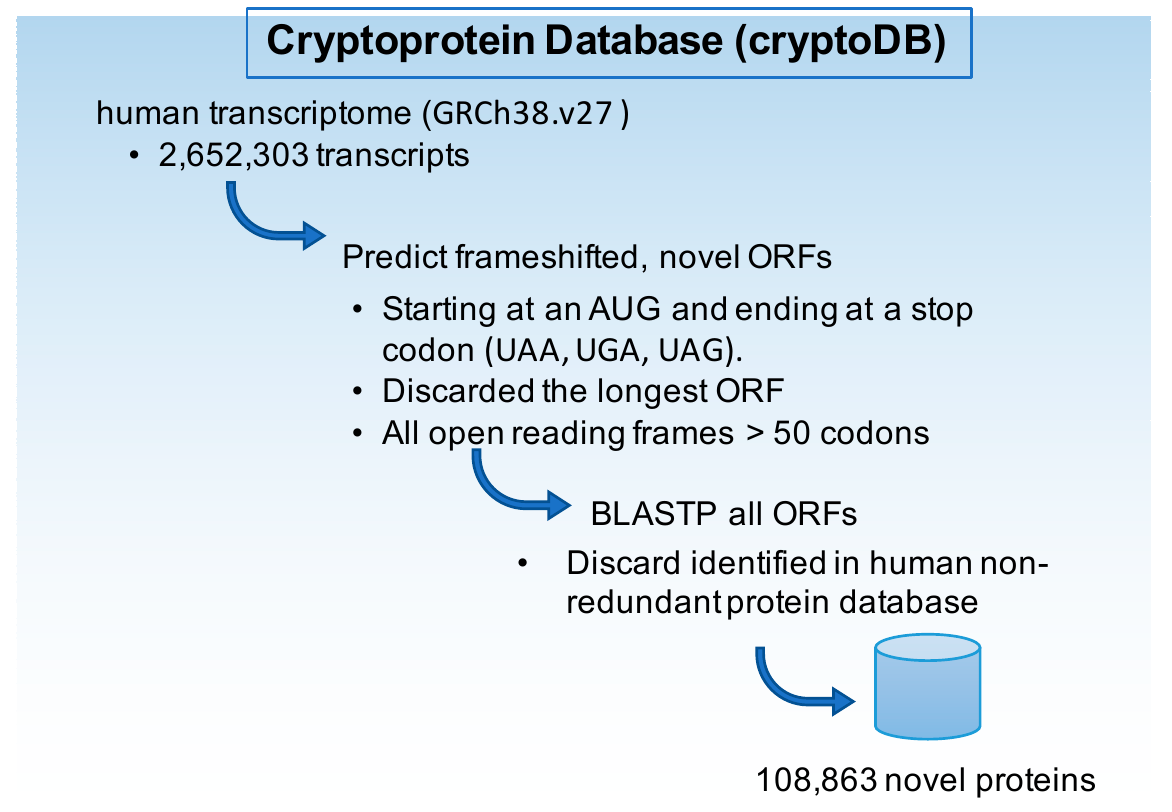
Figure 4. Construction of a cryptoprotein database (cryptoDB).